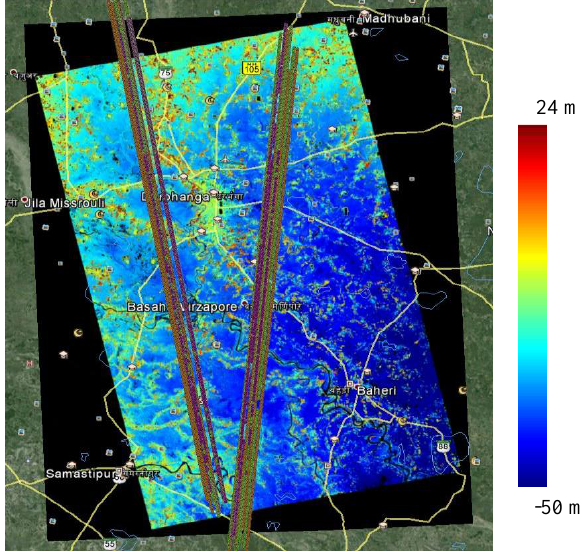
Figure 1. Bihar test area coverage on Google map showing towns, ICESat passes and TanDEM-X DEM in colour scale.